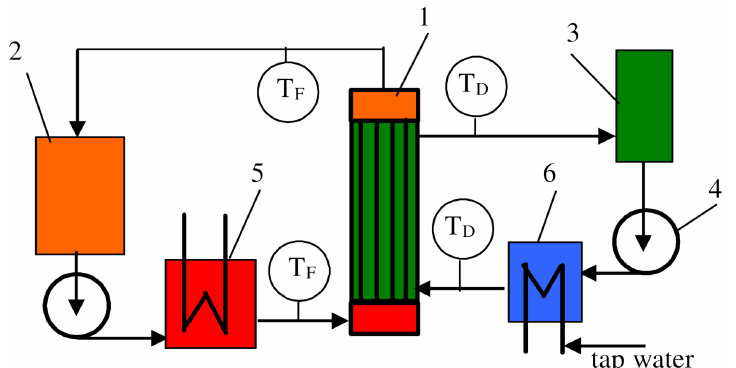
Figure 2. Schematic diagram of the MD installation: 1—capillary module, 2—feed tank, 3—distillate tank, 4—peristaltic pump, 5—heat exchanger, 6—cooler, T—thermometer. F—feed,